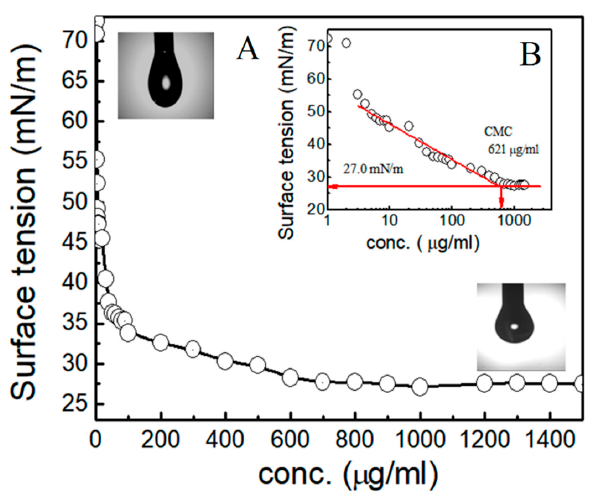
Figure 2. ( A ) Variation in surface tension and ( B ) semi-logarithmic reflection of critical micelle concentration (CMC) value from surface tension (SFT) (mN/m) versus biosurfactant (BS) concentration.